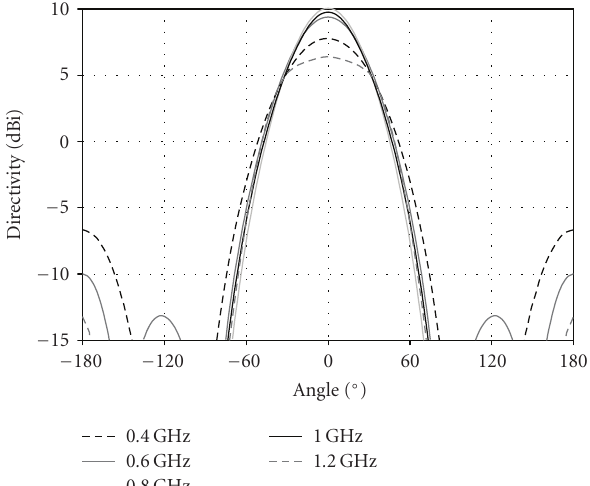
Figure 19: Directivity versus the dipole length.